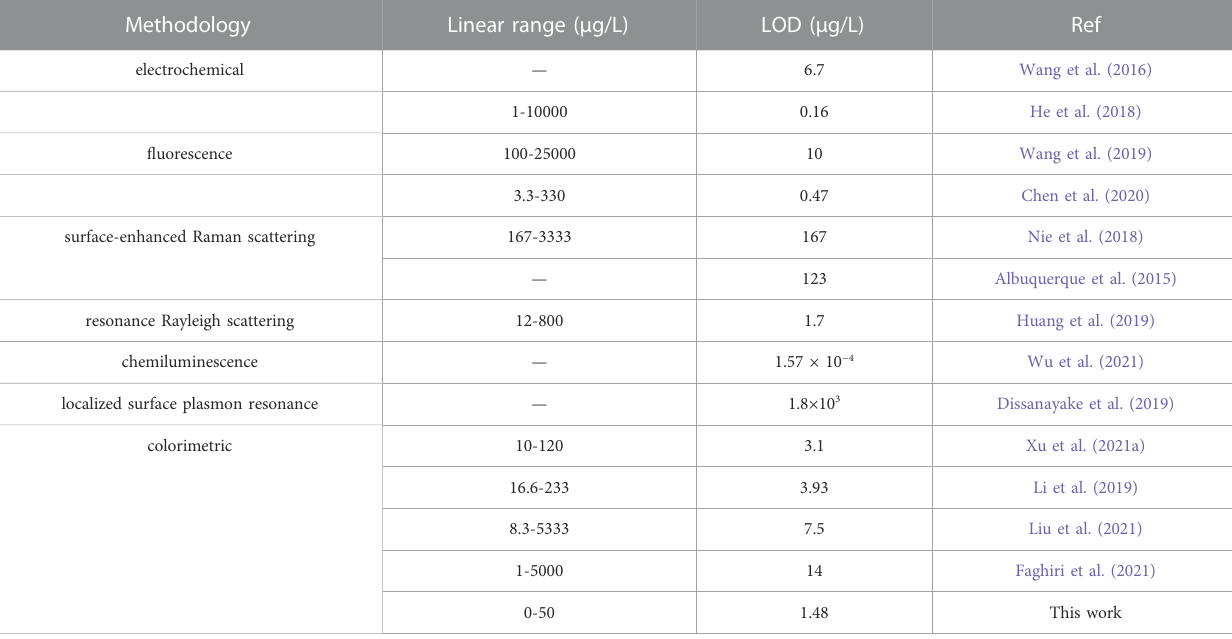
TABLE 1 The performance comparison of malathion detection